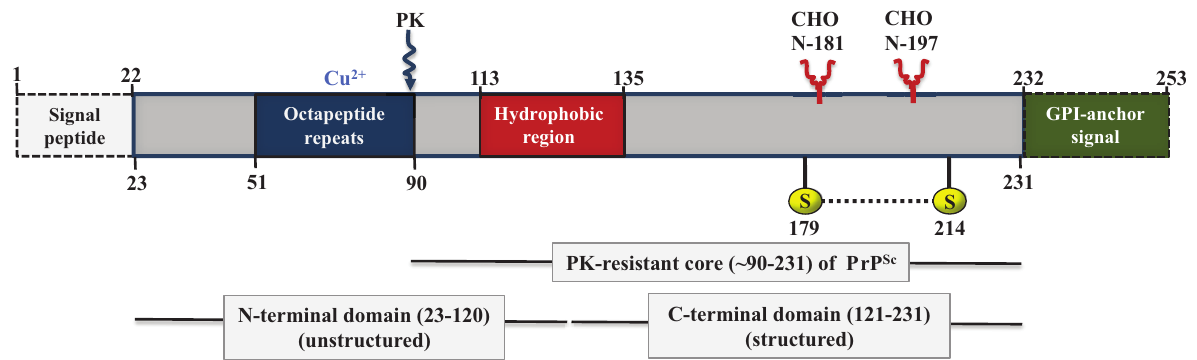
Figure 2. Organization of human PrP. The unprocessed PrP is 253 amino acid residues in length and includes a signal peptide (1 – 22), four OR, a hydrophobic region (113 – 135), one disulphide bond between cysteine residues (179 – 214), two N -linked glycosylation sites (at residues 181 and 197), and a GPI-anchor attached to the C -terminus of PrP replacing the GPI-anchor signal (residues 232 to 254). The four OR in the N -terminal domain have a high affinity for copper ions (Cu 2+ ), while a preceding nonapeptide (PQGGGGWGQ) lacks the histidine that is necessary to bind a Cu 2+ ion. Mutated forms of PrP can contain insertions of one to nine additional OR or a deletion of one OR. A palindromic region, AGAAAAGA (113 – 120), lies in the hydrophobic region (113 – 135) and is thought to